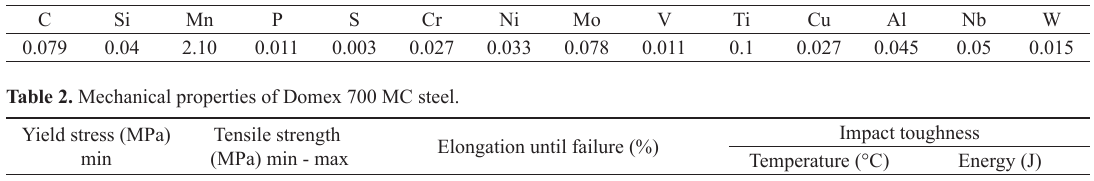
Table 1. Chemical composition of Domex 700 MC steel.